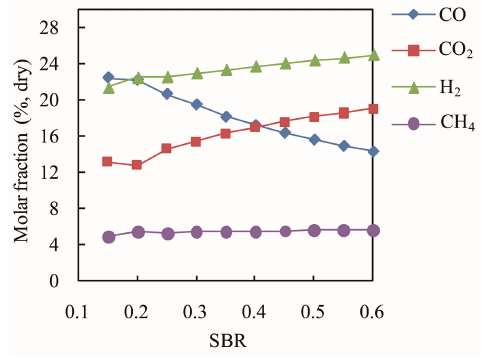
Figure 17. Effect of SBR on syngas composition at T = 1100 K and ER = 0.2.